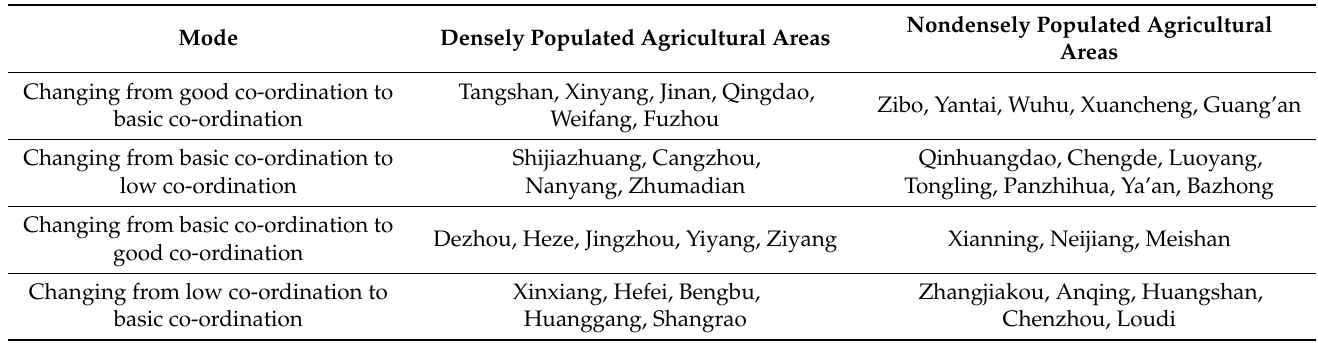
Table 8. Changes in the co-ordinated development modes during 2010–2018. Mode Densely Populated Agricultural Areas